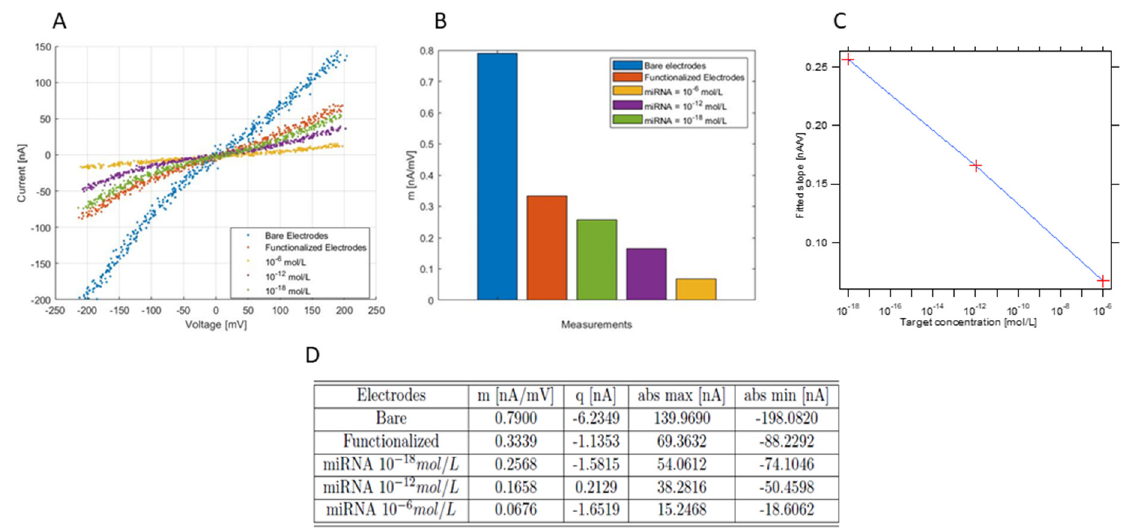
Figure 5. ( A ) Example of CV experiments for the hybridization in channel A (see Figure 4B). Blue curve for the bare electrodes, red curve for functionalized electrodes with ssDNA probes, green curve for a miRNA target concentration of 10 − 18 mol/L, purple curve for a miRNA target concentration of 10 − 12 mol/L, yellow curve for a miRNA target concentration of 10 − 6 mol/L. ( B ) Histogram representing the extracted slope by MatLab for each CV curve in Figure 5A. ( C ) Graph representing the three slopes for the hybridization process respect to target concentration in log scale representation. ( D ). Table for the five measurements in which the important values are extracted by an implemented MatLab code. The first column, m , represents the slope parameter, q the intercept of the fit, abs max the CV curve absolute maximum and abs min the CV curve absolute minimum.